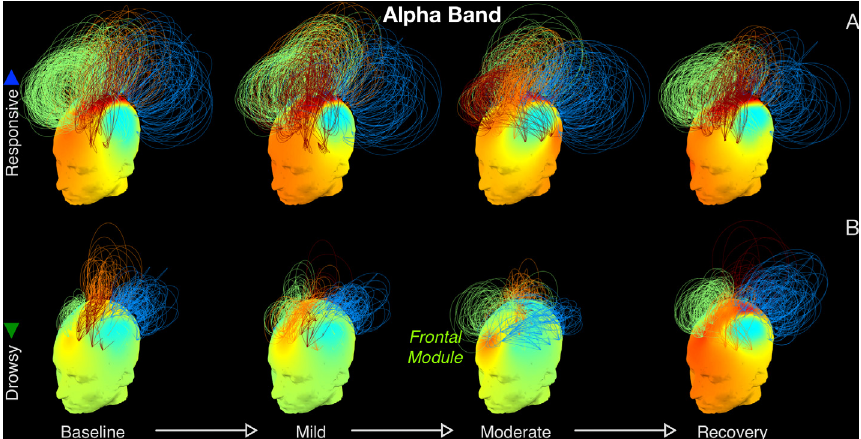
Fig 4. Alpha band connectivity networks. Network topographs are visualised at each level of sedation, averaged over participants in the responsive (A) and drowsy (B) groups. Colour of the scalp indicates the degree of a node. The normalised height of an arc connecting two nodes indicates the strength of the dwPLI link between them. Network modules were identified by the Louvain algorithm. For visual clarity, of the strongest 30% of links, only the intra-modular links are plotted. The colour of an arc identifies the module to which it belongs. While alpha band networks in the responsive group exhibited a relatively stable fronto- centro-occipital pattern of connectivity, the drowsy group altered significantly, and registered a pronounced frontally centered module during moderate sedation.